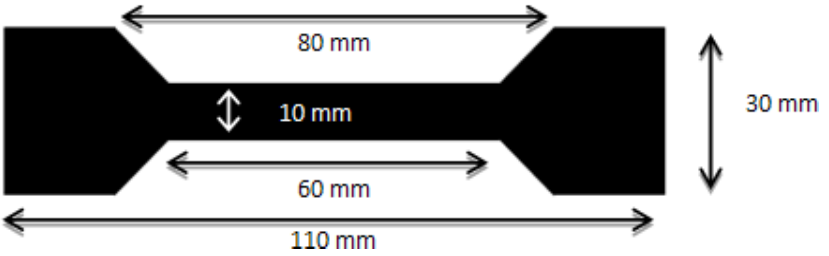
Figure 1. Film dimensions for mechanical testing of CPP105D/PVA